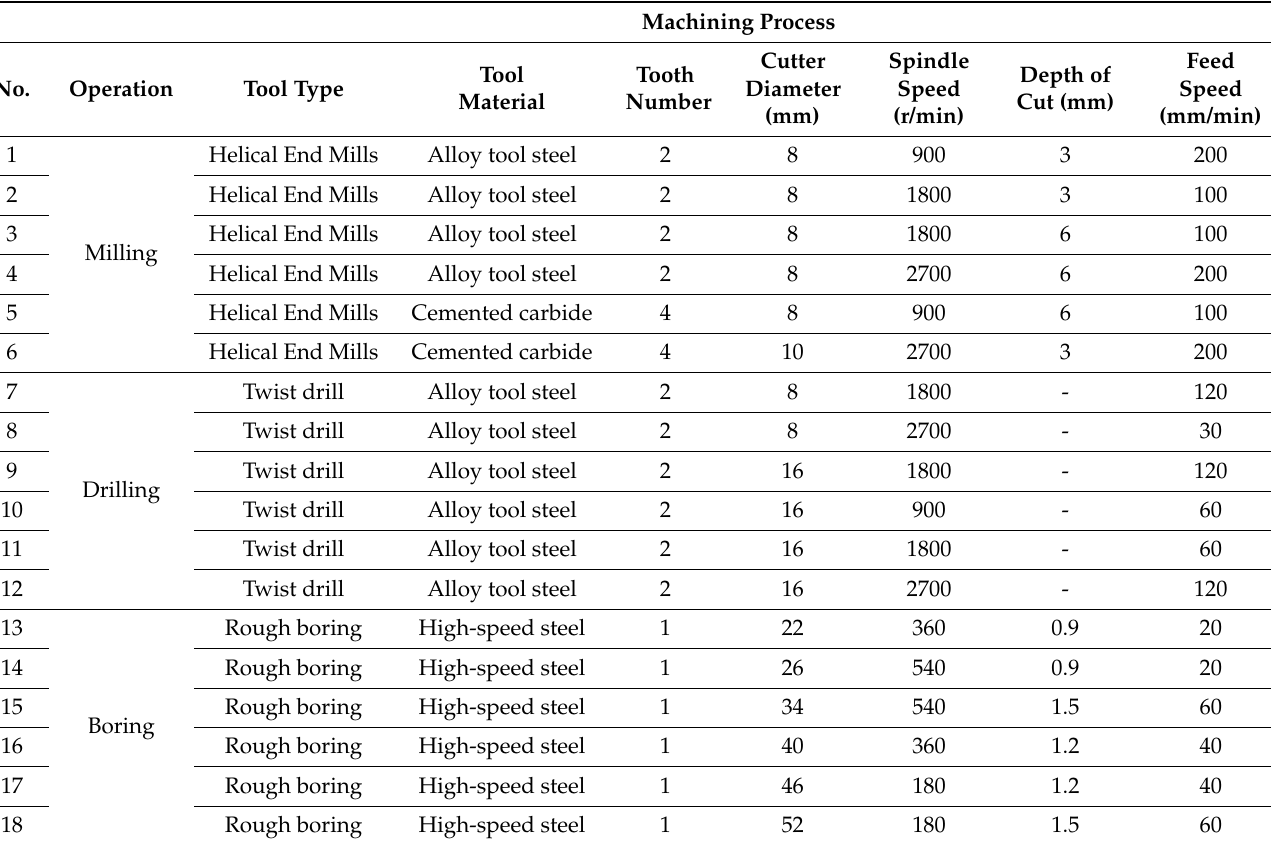
Table 1. Experimental design of different workload